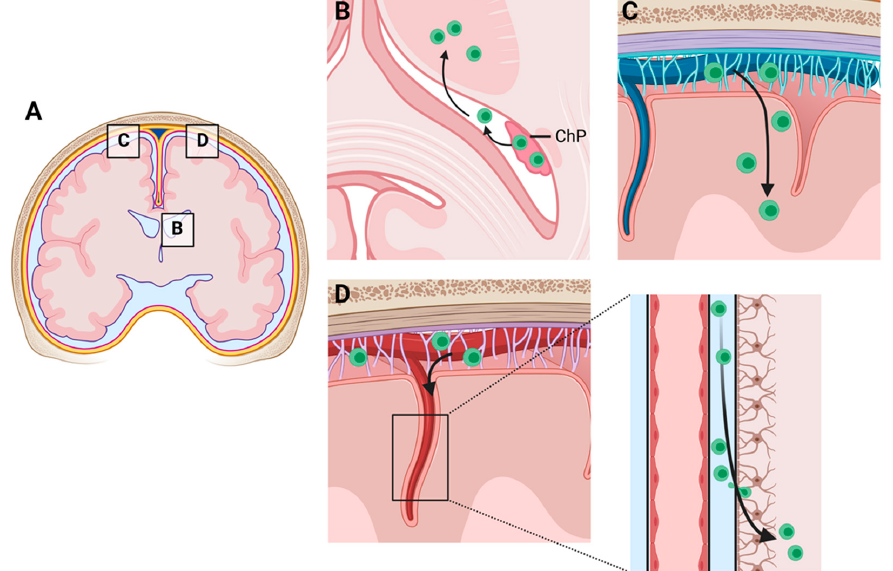
Figure 1. Schematic illustration of alternative routes for peripheral immune cell recruitment into the central nervous system. ( A ) Overview. ( B ) Immune cell recruitment across the blood–CSF barrier, also called the blood–liquor barrier. This barrier restricts the passage of substances from the blood into the liquor. ( C ) Immune cell recruitment via leptomeningeal vessels into the subarachnoid space and from there through the glia limitans superficialis directly into the brain parenchyma. ( D ) Alternatively, immune cells within the subarachnoid space can migrate along the penetrating brain vessels, driven by the glymphatic flow, into the depths of the brain. See Figure 2 for experimental proof of this migration route. (Created with BioRender.com, access date on 5 August